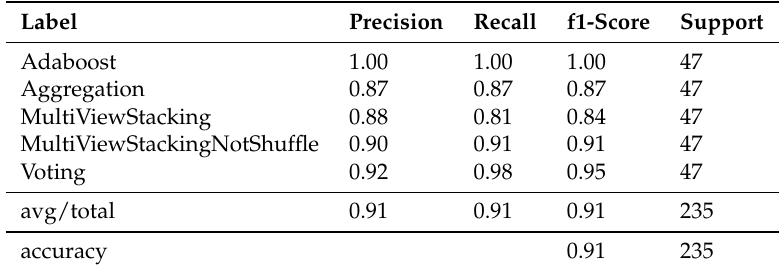
Table 14. Performance metrics of RFC based on the Statistical signature data